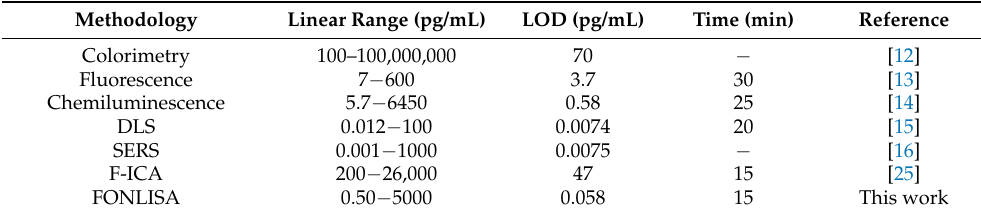
Table 1. Comparison of optical biosensors for NT-proBNP